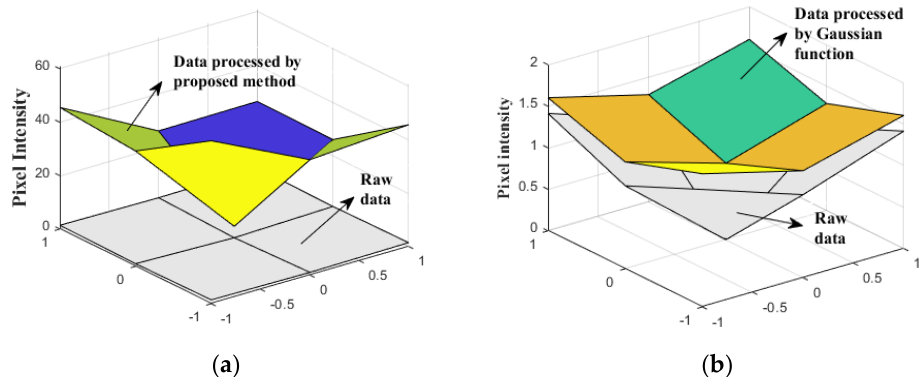
Figure 4. The schematic diagram of local gradient change. ( a ) uses Gaussian functions to aggregate information from different directions; ( b ) filters using Gaussian functions.